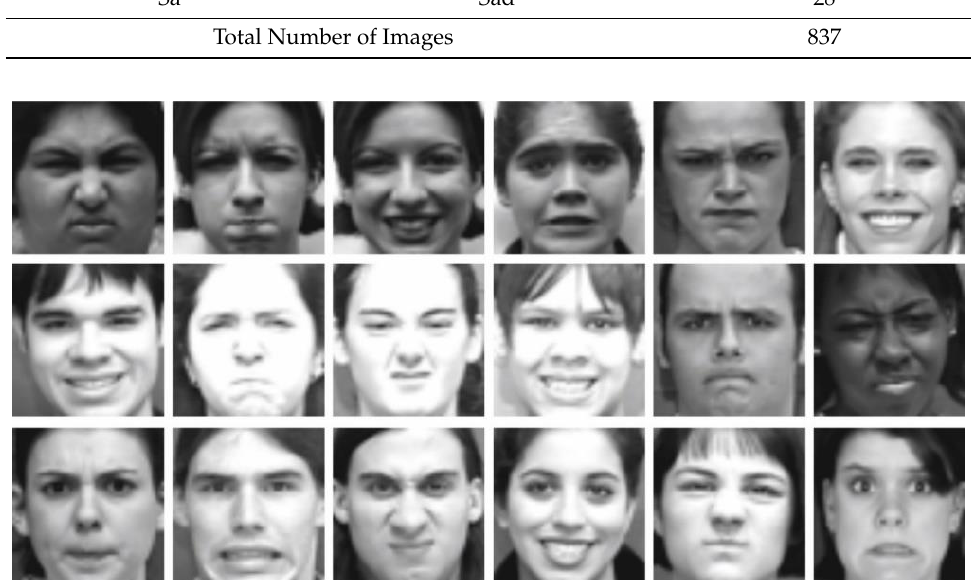
Figure 4. Sample images.